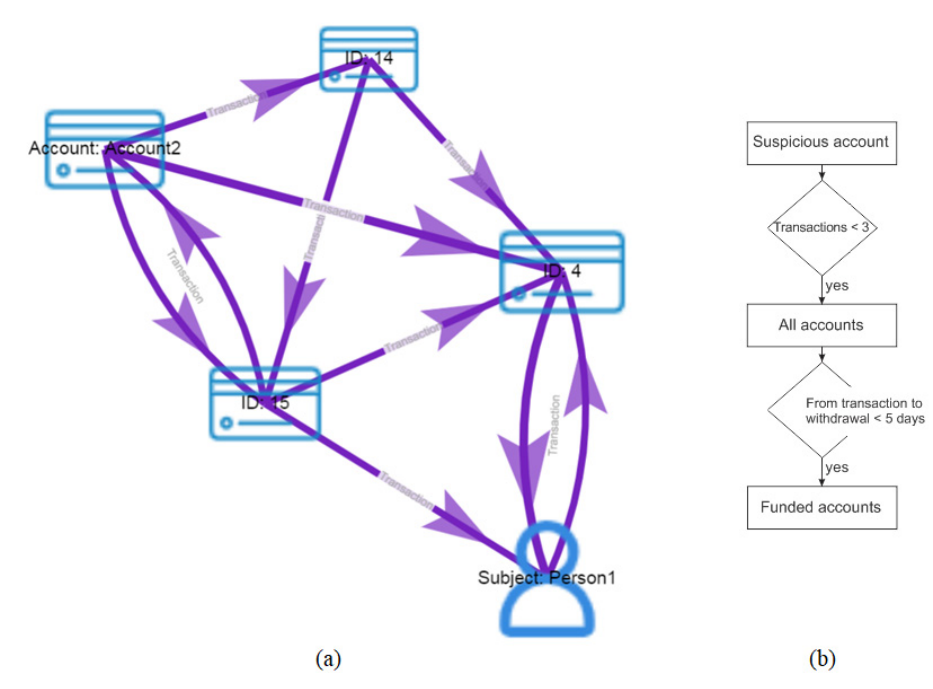
Figure 5. ( a ) The result of the final Cypher query, where the cycle of transactions can be seen and ( b ) the flowchart of the used Cypher query. ( b ) the flowchart of the used Cypher